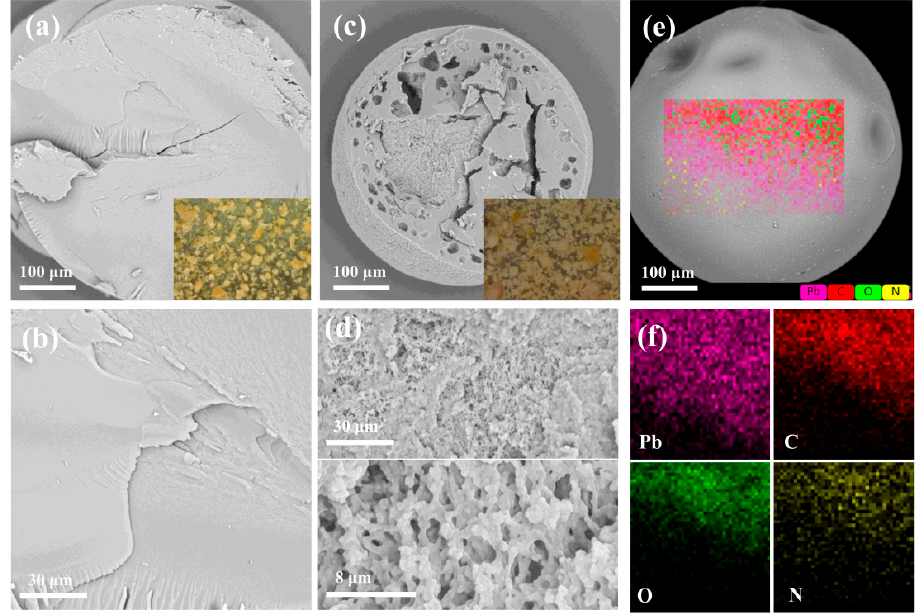
Figure 3. SEM images of ( a , b )WAO resin ( c , d ) MT-WAO-resin ( e , f ) EDS of MT-WAO resin after adsorbing Pb(II) .